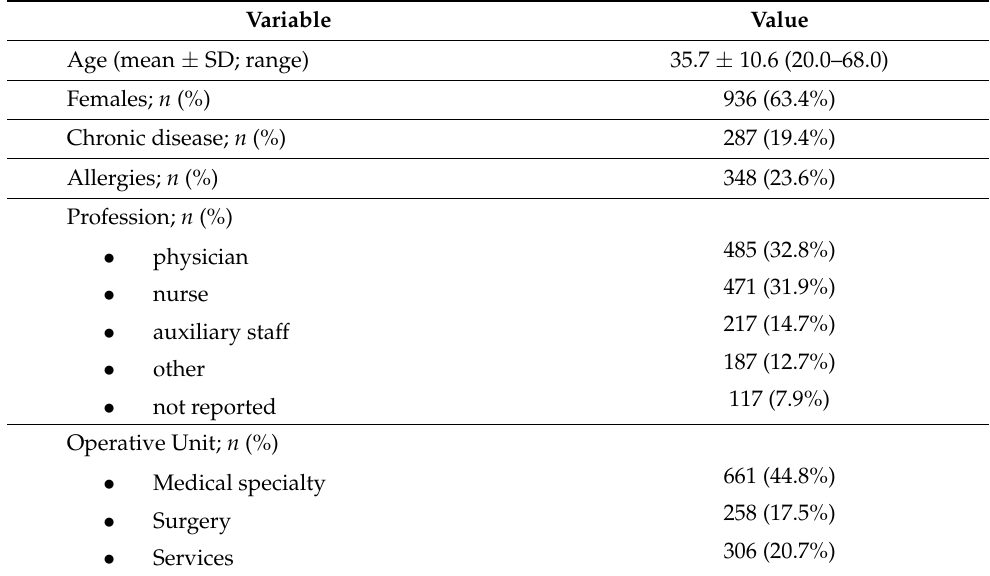
Table 1. Characteristics of the